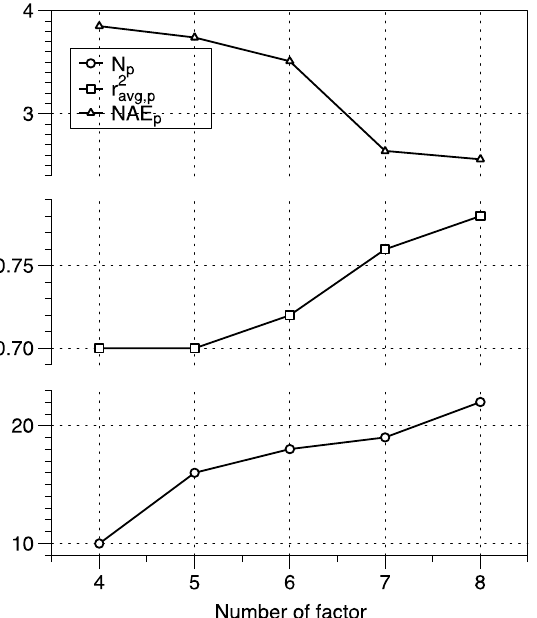
Figure 3. Statistical indicators used for factor selection: number of species with correlation coefficient greater than the threshold, N p (bottom panel); weighted average correlation coefficient, r 2 avg,p (middle panel); and normalized absolute error, NAE p (top panel).